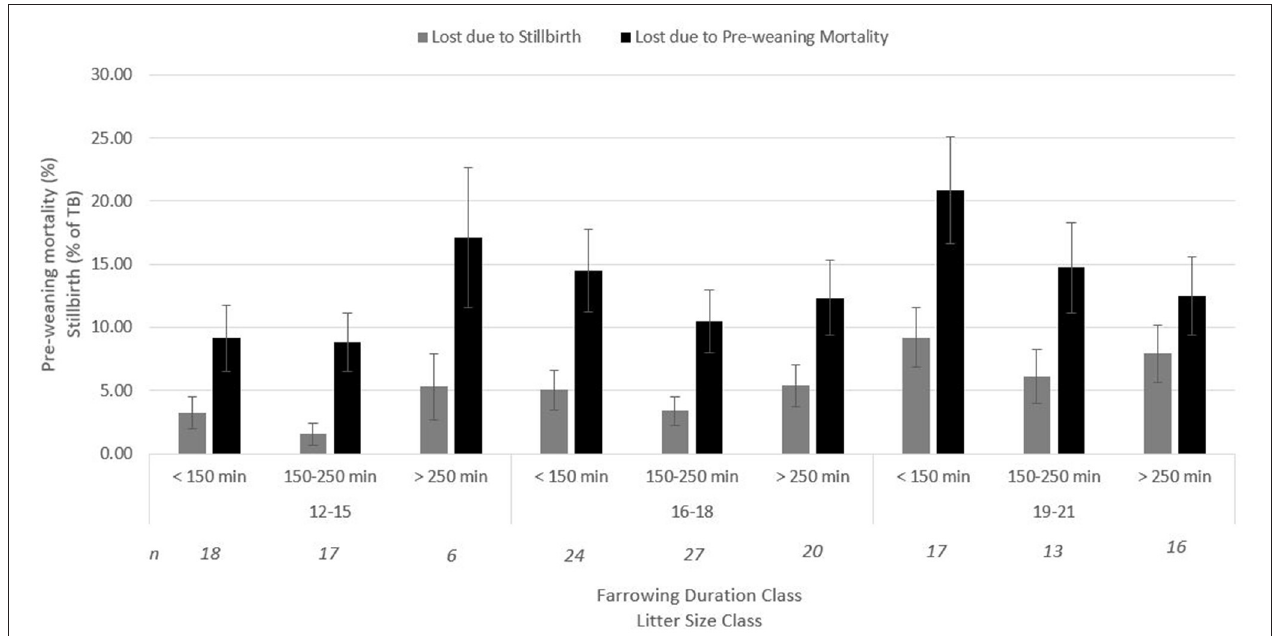
FIGURE 1 | Interaction between farrowing duration (classified) and litter size (classified) on percentage of stillbirth ( p = 0.77) and pre-weaning mortality ( p = 0.10) (Lsmeans ± SEM). n , number of litters per category.